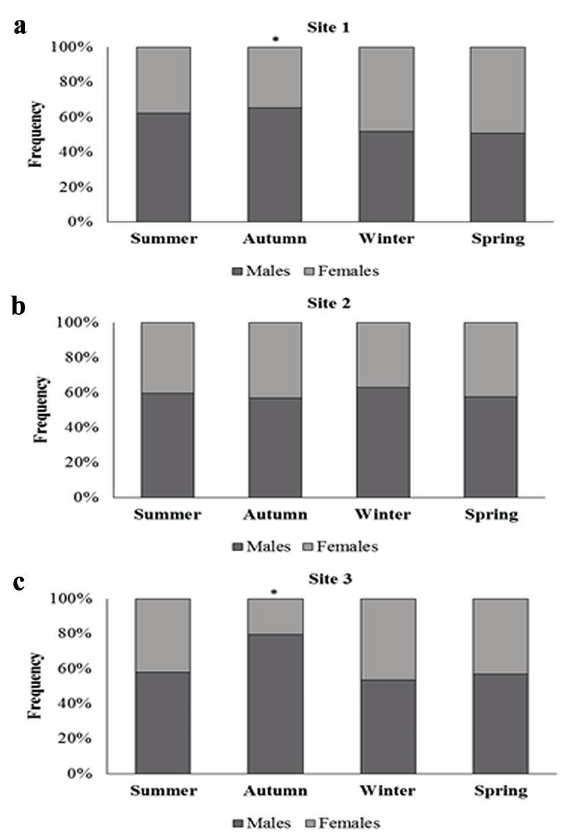
Figure 6 - Seasonal sex ratio of H. pampeana in ( a ) site 1, ( b ) site 2 and ( c ) site 3. The asterisk indicates significant differences in the proportion 1M: 1F